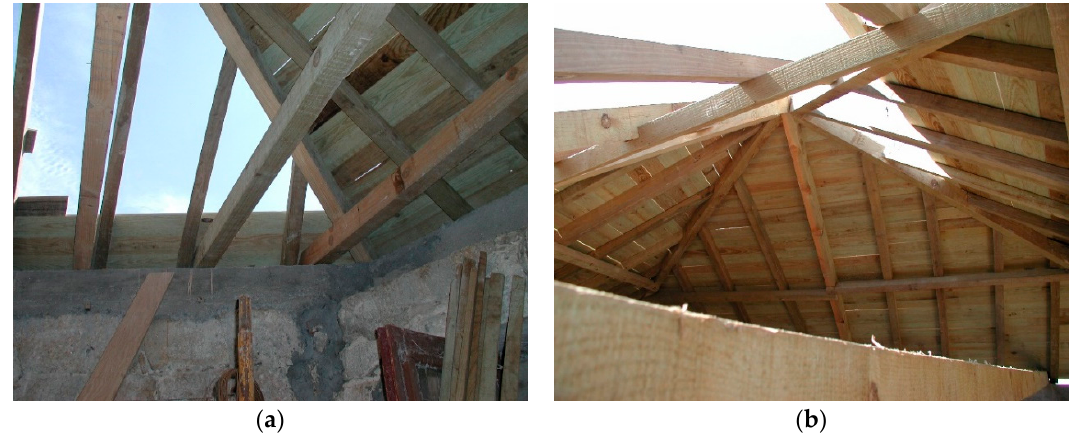
Figure 2. ( a , b ) Photograph of the hipped roof resting on party walls in Historic Center of Porto.